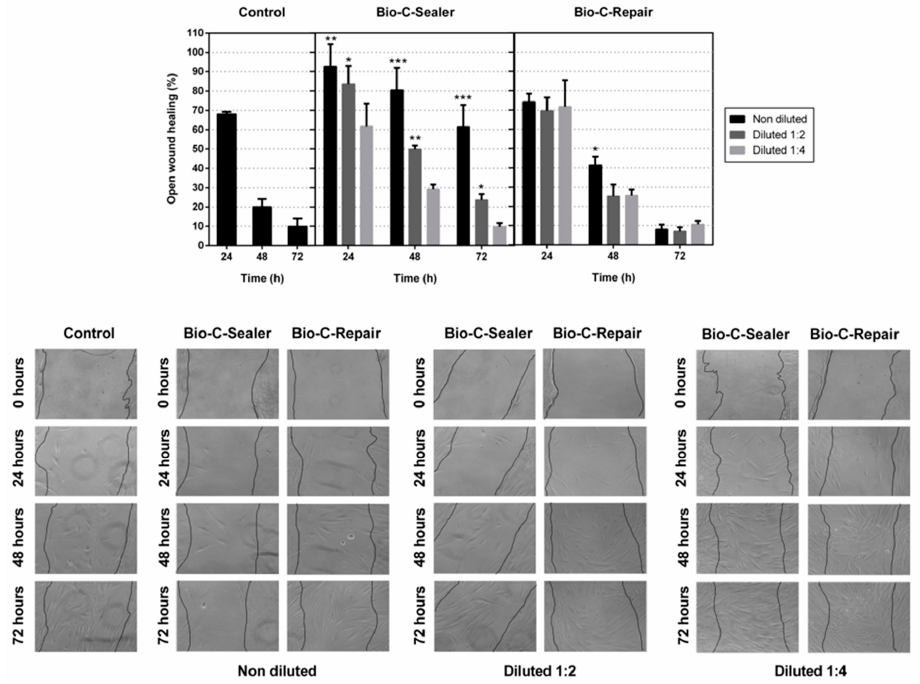
Figure 3. E ff ect of endodontic cement eluates on cellular migration on a wound healing assay. Confluent hPDLSCs were wounded and incubated with di ff erent dilutions of the material extracts for up to 72 hours. Cell migration is represented as the percentage of the open wound area for each condition compared with the control. Significant di ff erences are indicated as * p < 0.05; ** p < 0.01; *** p < 0.001,